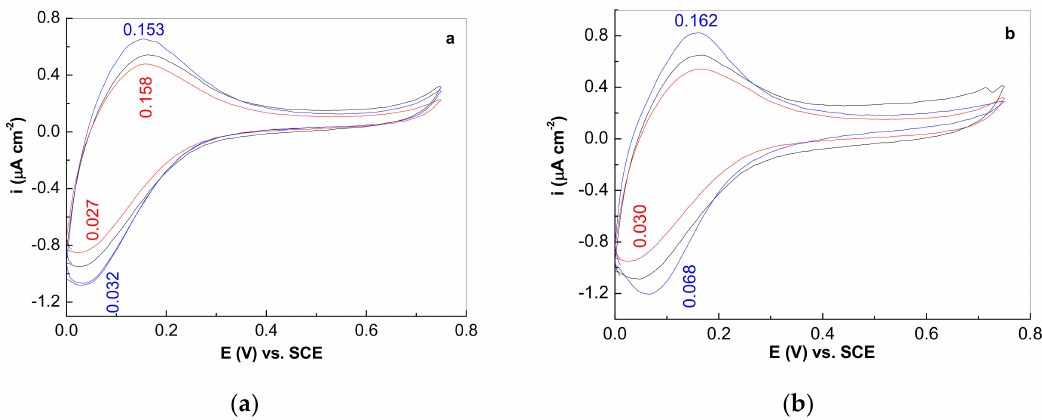
Figure 6. The 25th cyclic voltammogram recorded on the Au electrode ( a ) and the Au electrode covered with the RGO sheets ( b ), when the synthesis solution consists of 0.1 M HClO 4 , 10 − 3 M H 4 SiW 12 O 40 and 5A1N with the concentration 10 − 3 M (red curve), 5 × 10 − 3 M (black curve) or 10 − 2 M (blue curve), the scan rate being equal to 50 mV s − 1 .